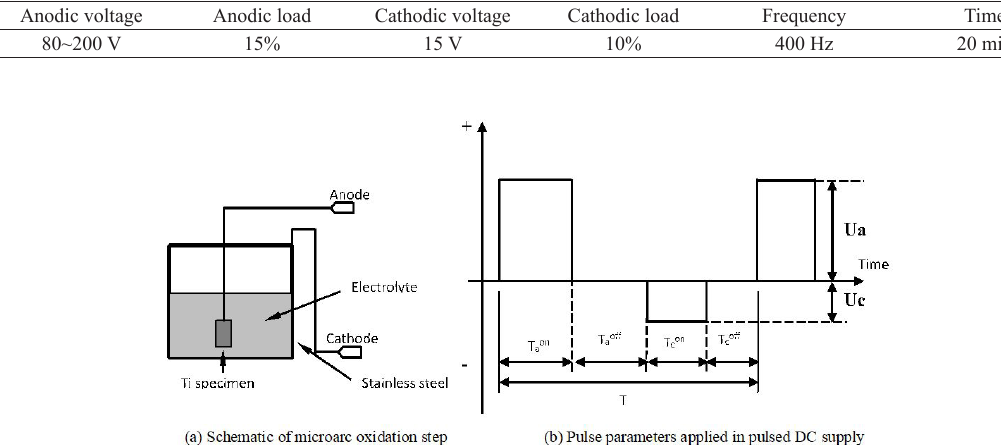
Figure 1. (a) Schematic of microarc oxidation step, (b) Pulse parameters applied in pulsed DC